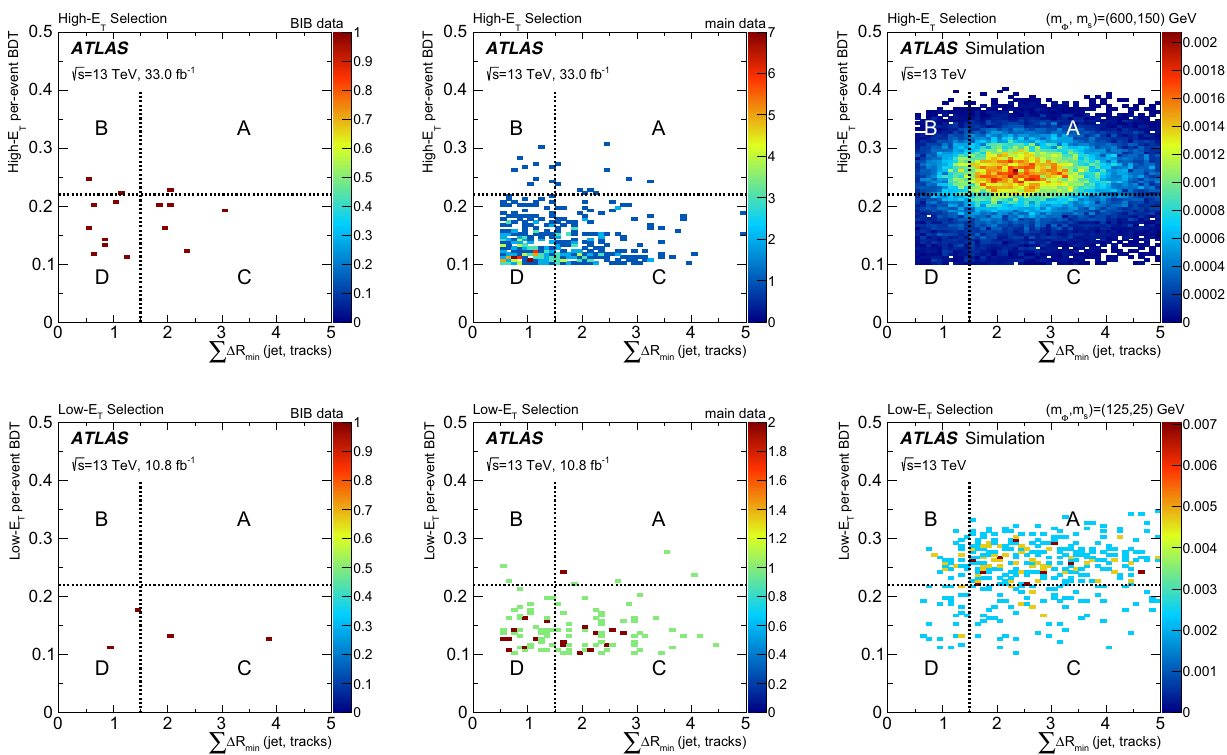
(cid:3) (cid:8) R Fig. 6 The distributions of and m s = 25 GeV sample is shown for the low- E T selection. Signal min (jet, tracks) versus high- E T plots are shown as a probability density. The black dashed lines indicate per-event BDT (top row) and low- E T per-event BDT (bottom row) for the boundaries defining regions A, B, C and D in the plane after event BIB events (left), main data (centre) and a signal sample (right) after selection event selection. The signal sample with m (cid:4) = 600 GeV and m s = 150 GeV is shown for the high- E T selection, while the m (cid:4) = 125 GeV